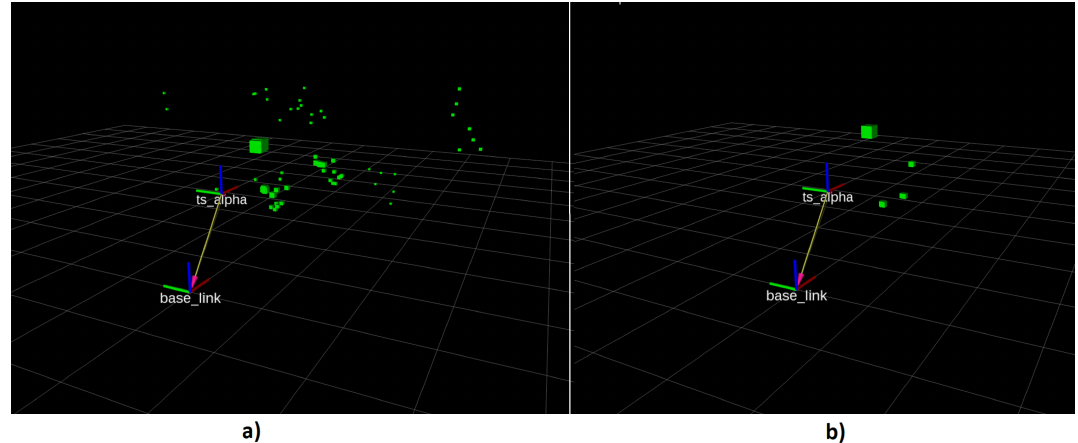
Figure 5. ( a ) 3D ultrasound raw data ( b ) 3D ultrasound after being